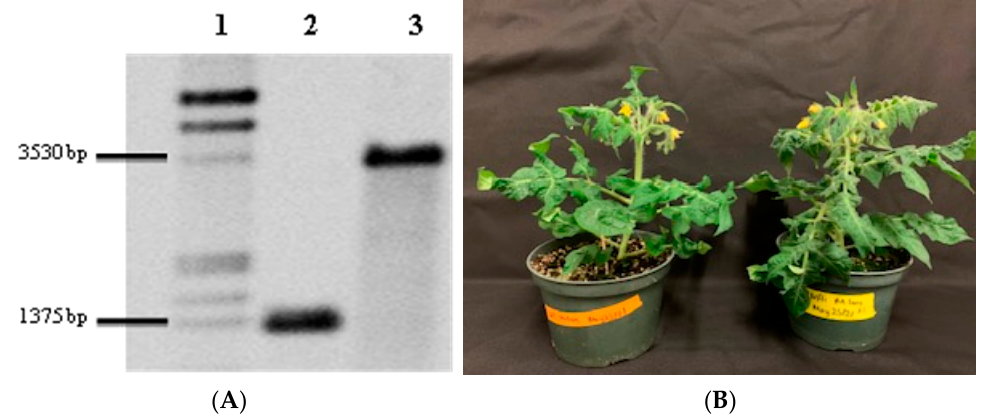
Figure 2. Southern blot analysis and phenotype of Micro-tom plants. ( A ) Southern blot confirming production of homoplastomic tpMicro-tom plants. Ten micrograms of total DNA was digested using Mfe I restriction enzyme, and the DNA fragments were separated on a 0.8% agarose gel for blotting. Lane 1 = Dig-labelled DNA ladder III (Roche); Lane 2 = WT Micro-tom (1298 bp); Lane 3 = tpMicro-tom (3353 bp). ( B ) Phenotype comparison of 8-week-old WT Micro-tom and T 1 tpMicro-tom plants. The seeds were first germinated on Murashige and Skoog (MS) medium, and the plants